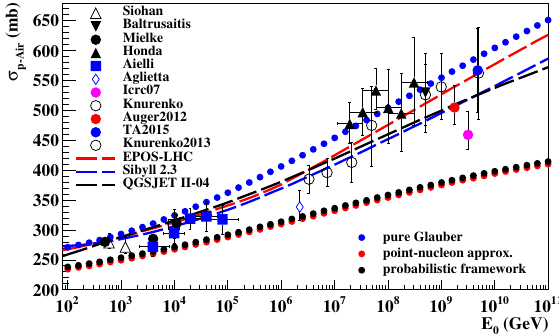
Figure 1. p-Air inelastic cross-section calculated using Glauber theory, point-nucleon approximation and probabilistic frame- work compared with experimental data